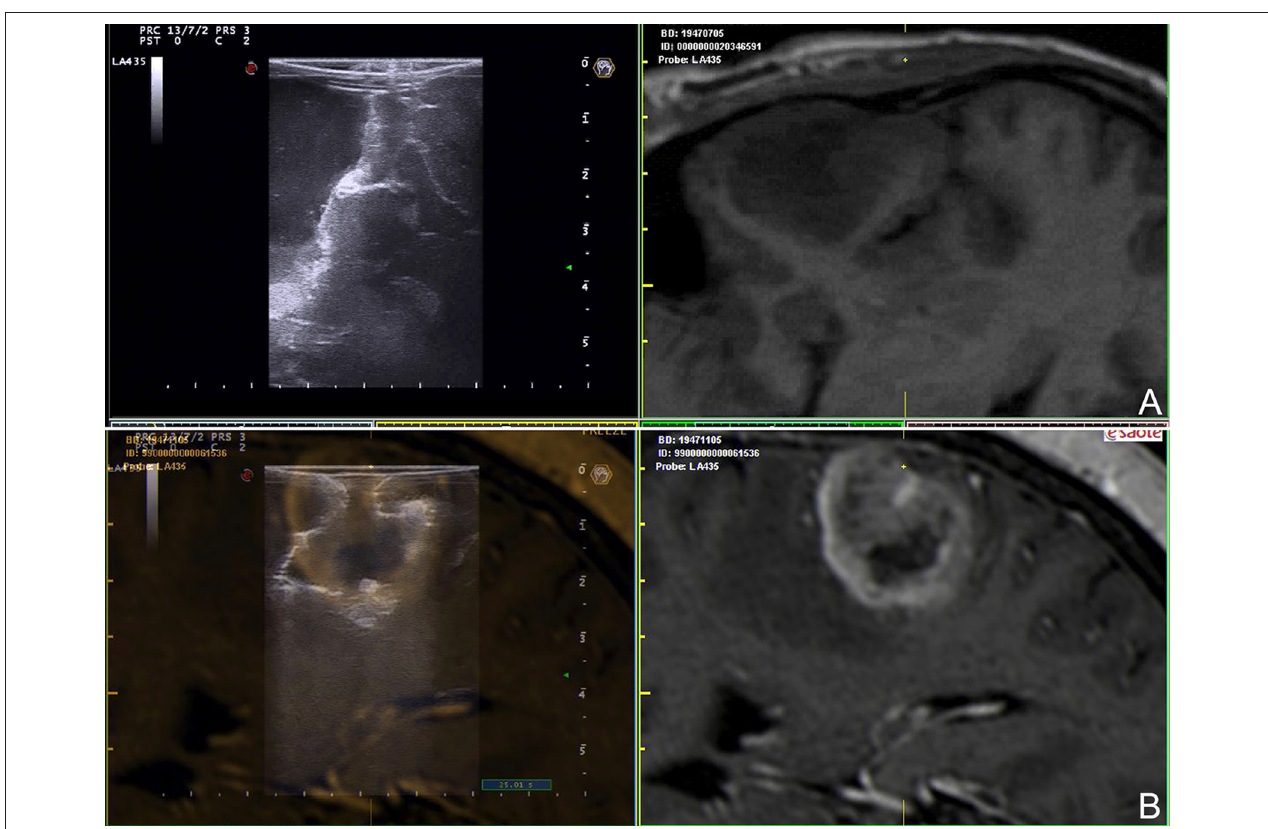
FIGURE 3 | Navigated intra-operative B-mode US in the final stages of surgery. (A) Left temporal anaplastic astrocytoma. (B) Right fronto-temporal glioblastoma. The comparison between ioUS and corresponding pre-operative MRI aid in identifying residual tumor and understanding ioUS semiotics: (A) side-by-side view, (B)